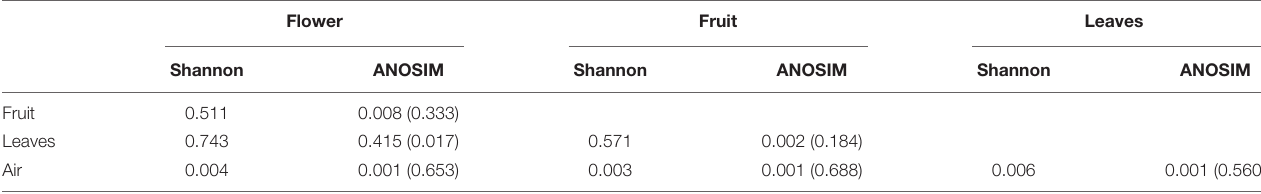
TABLE 2 | Comparisons between grape organs (flowers, fruits, and leaves) and air samples regardless of the sampling time using alpha (Shannon index) and beta diversity (Bray–Curtis metric). Flower Fruit Leaves Shannon ANOSIM